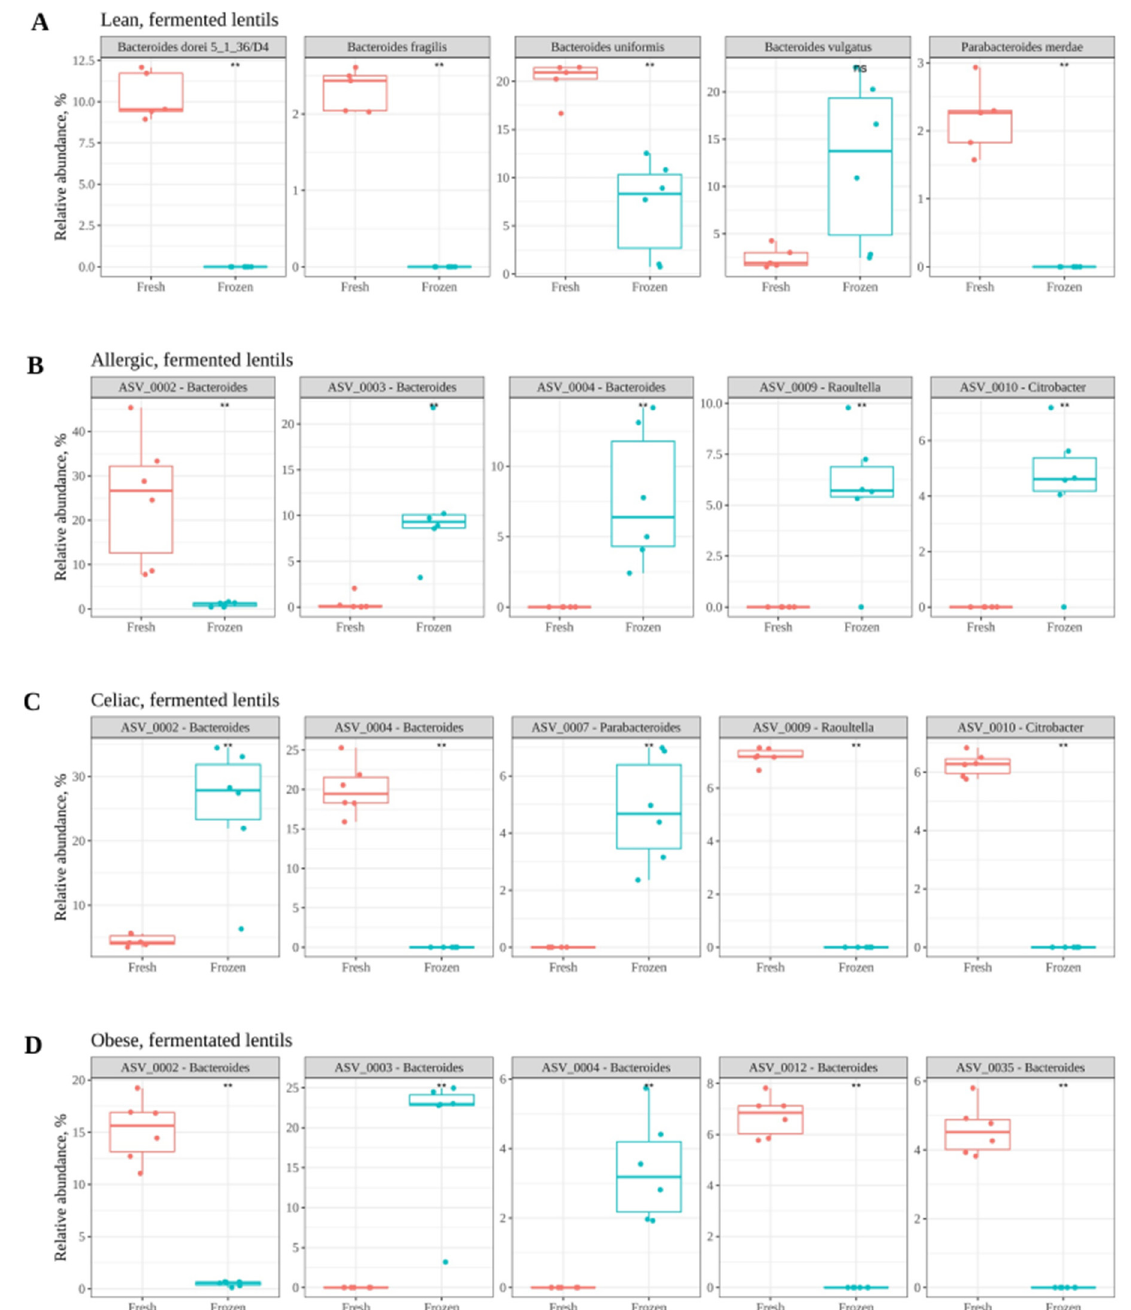
Figure 5. Top five discriminant ASVs between fresh and frozen samples after in vitro fermentation of lentils, as determined via OPLS-DA. ( A ) show the results obtained with fecal samples of lean children. ( B ) show the results obtained with fecal samples of children with allergy to cow’s milk. ( C ) show the results obtained with fecal samples of celiac children. ( D ) show the results obtained with fecal samples of obese children. Statistical significance was obtained via Wilcoxon test ( p < 0.05). Significance labels: ns: not significant; ** p < 0.01.